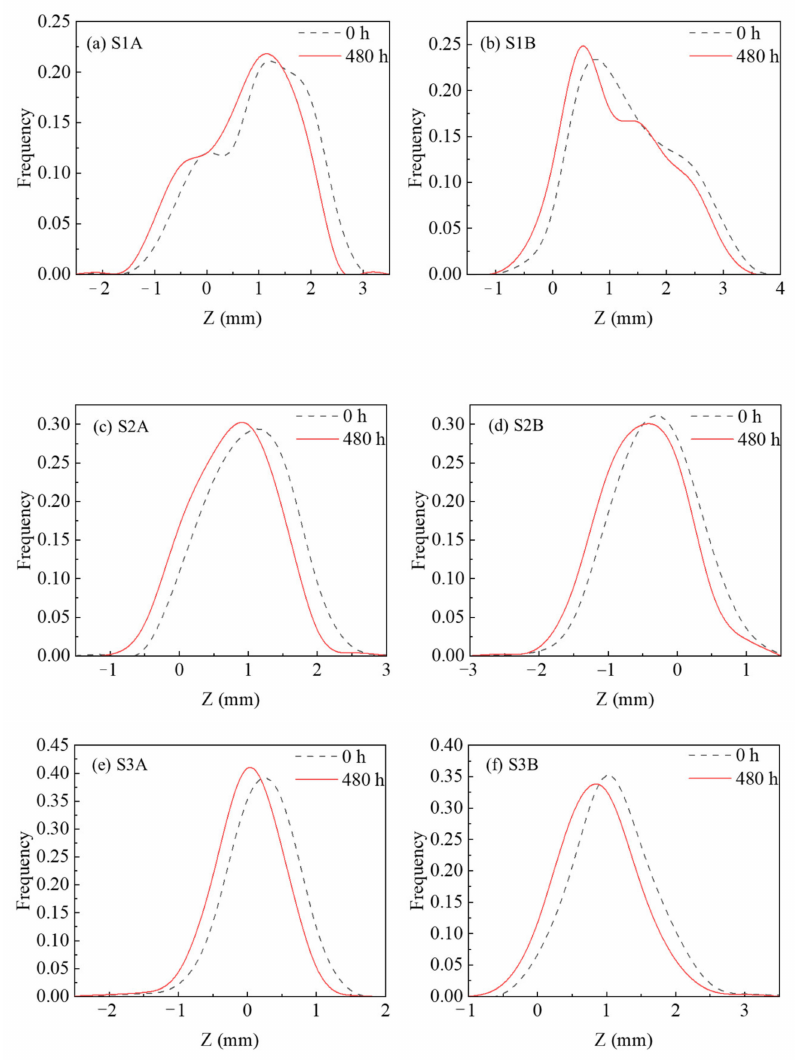
Figure 10. Temporal evolutions in elevation distribution